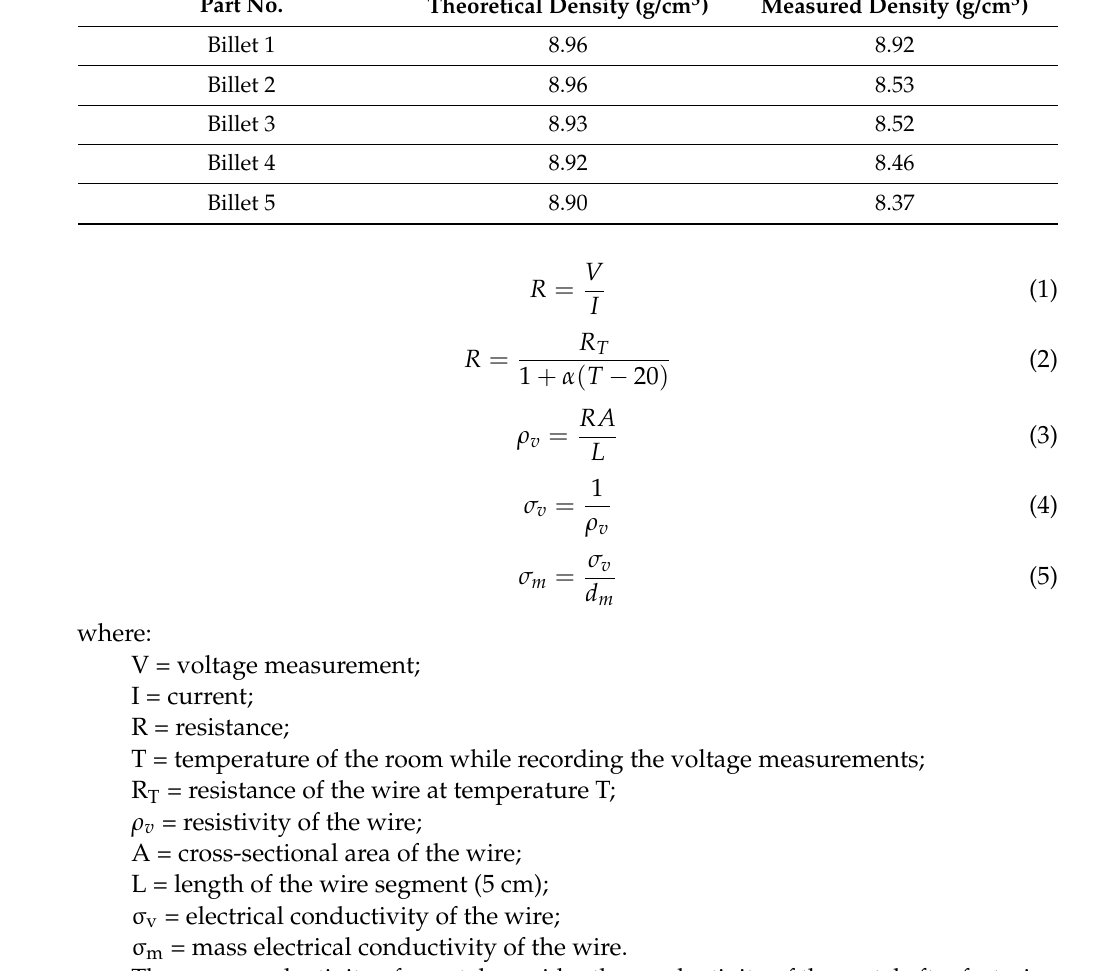
Table 2. Theoretical and Measured Densities of the Billets. Part